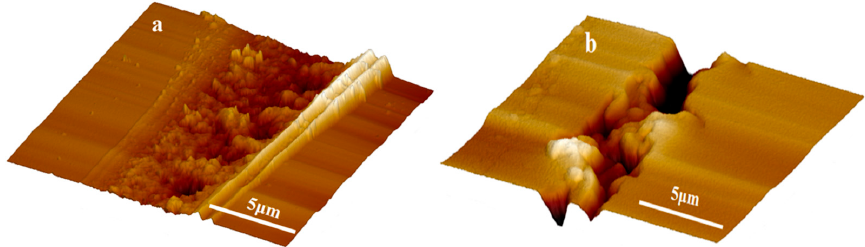
Figure 9. AFM images of scratch after healing for the ( a ) TMMP-TMTGE self-healing material and ( b ) TO/TMMP-TMTGE self-healing composite.